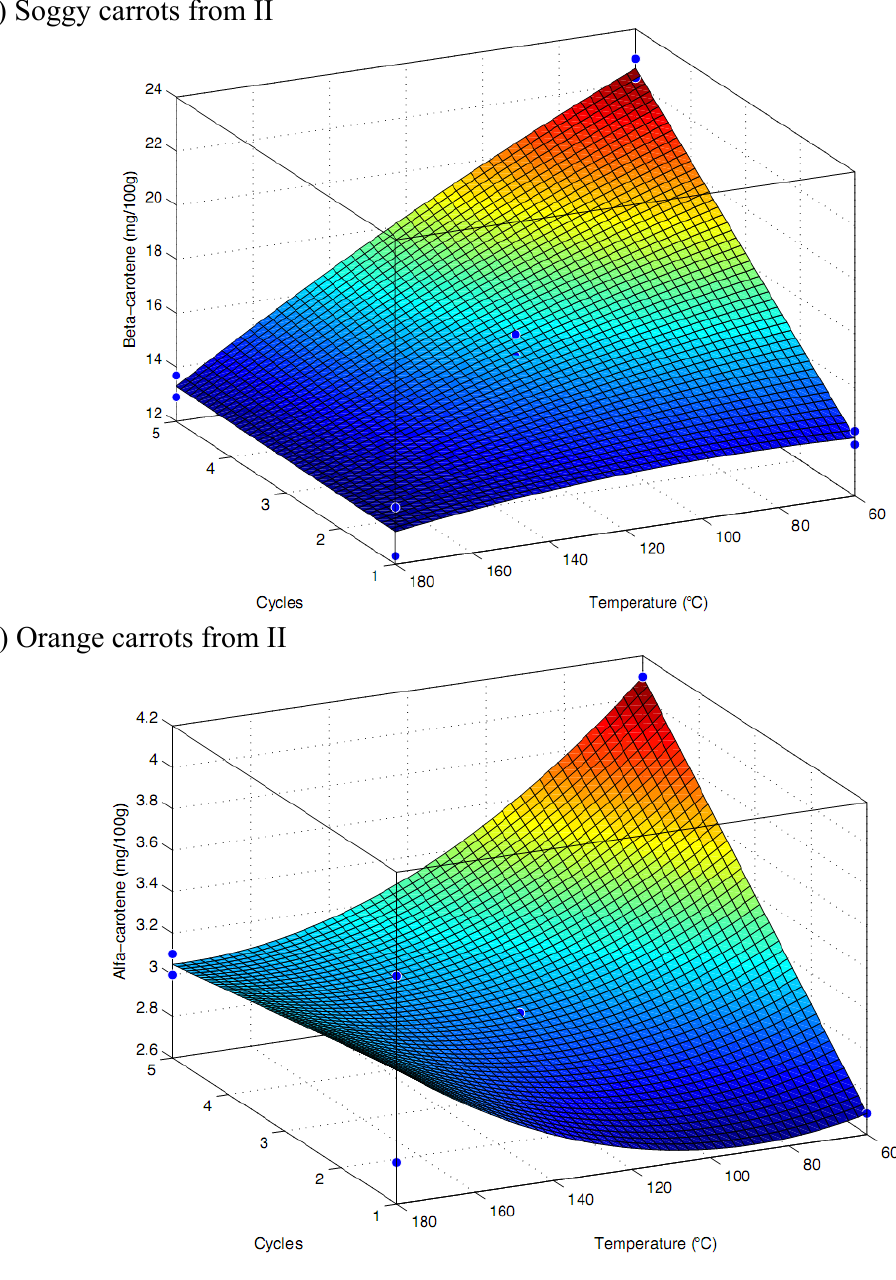
Figure 1. Surface plot showing the effect of time and temperature of extraction on the yield of α and β -carotene (mg/100 g FW). 1 cycle = 2 min